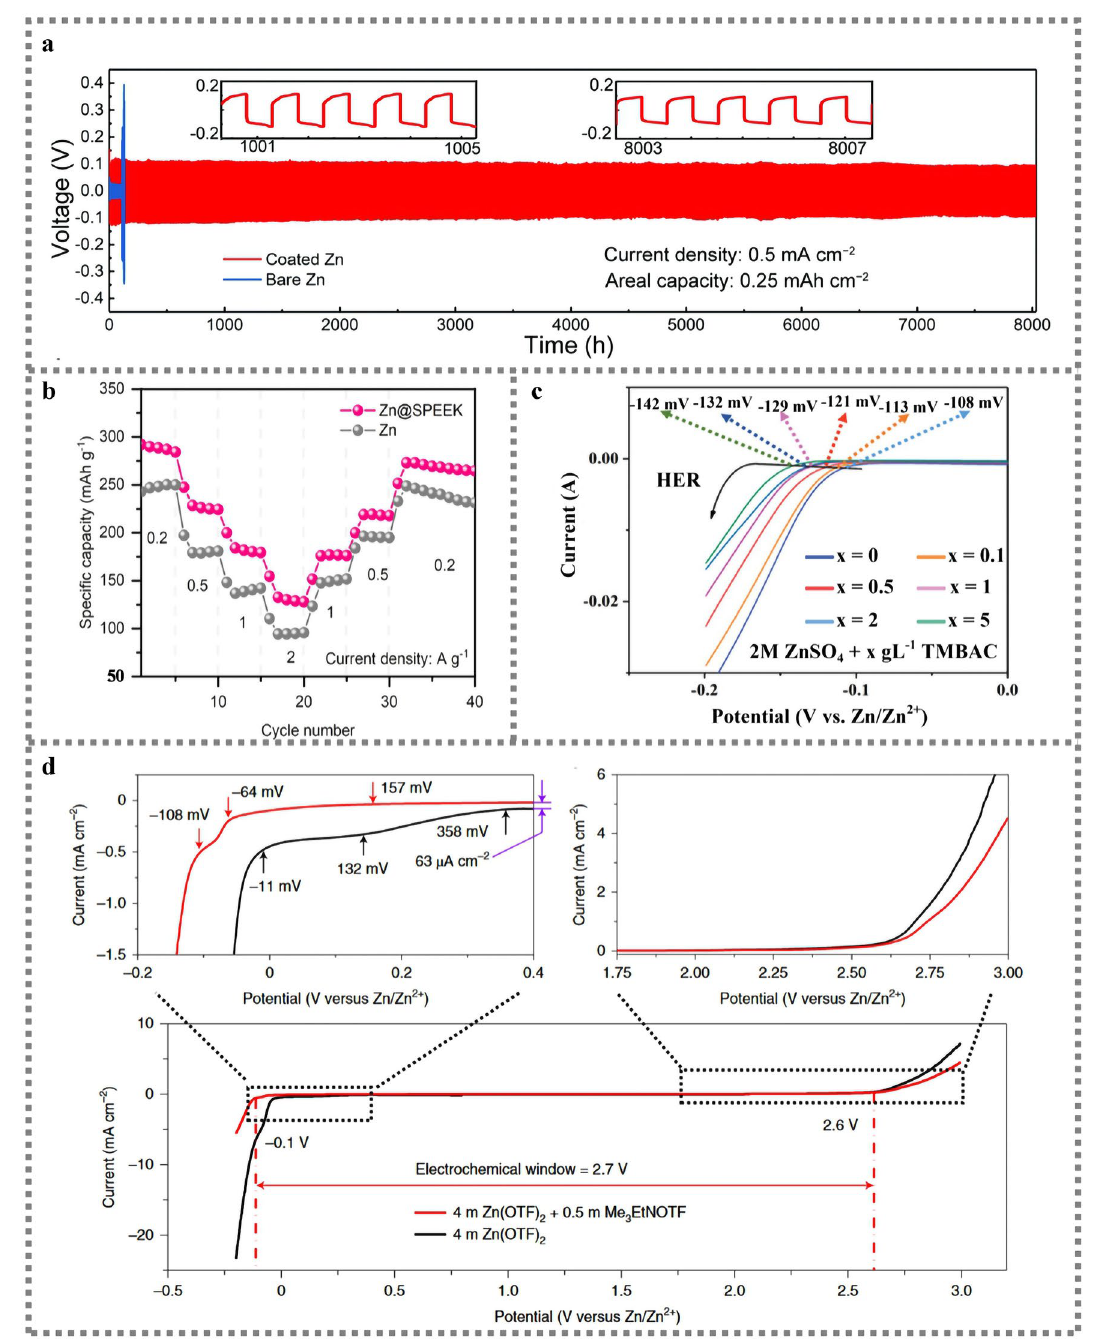
Fig. 9 a Long-term galvanostatic cycling of symmetrical Zn cells with coated Zn plates and bare Zn plates [47]; Copyright 2019, Royal Society of Chemistry. b The rate performance of the full cells with varying Zn anodes operating [94]; Copyright 2021, ACS Publication. c LSV curves (HER) in ZnSO 4 electrolyte with different TMBAC concentrations [96]; Copyright 2022, Wiley–VCH. d The electrochemical stability window of aqueous electrolytes measured using polarization scanning on non-active Ti electrodes versus Zn/Zn 2+ [39]. Copyright 2021, Springer